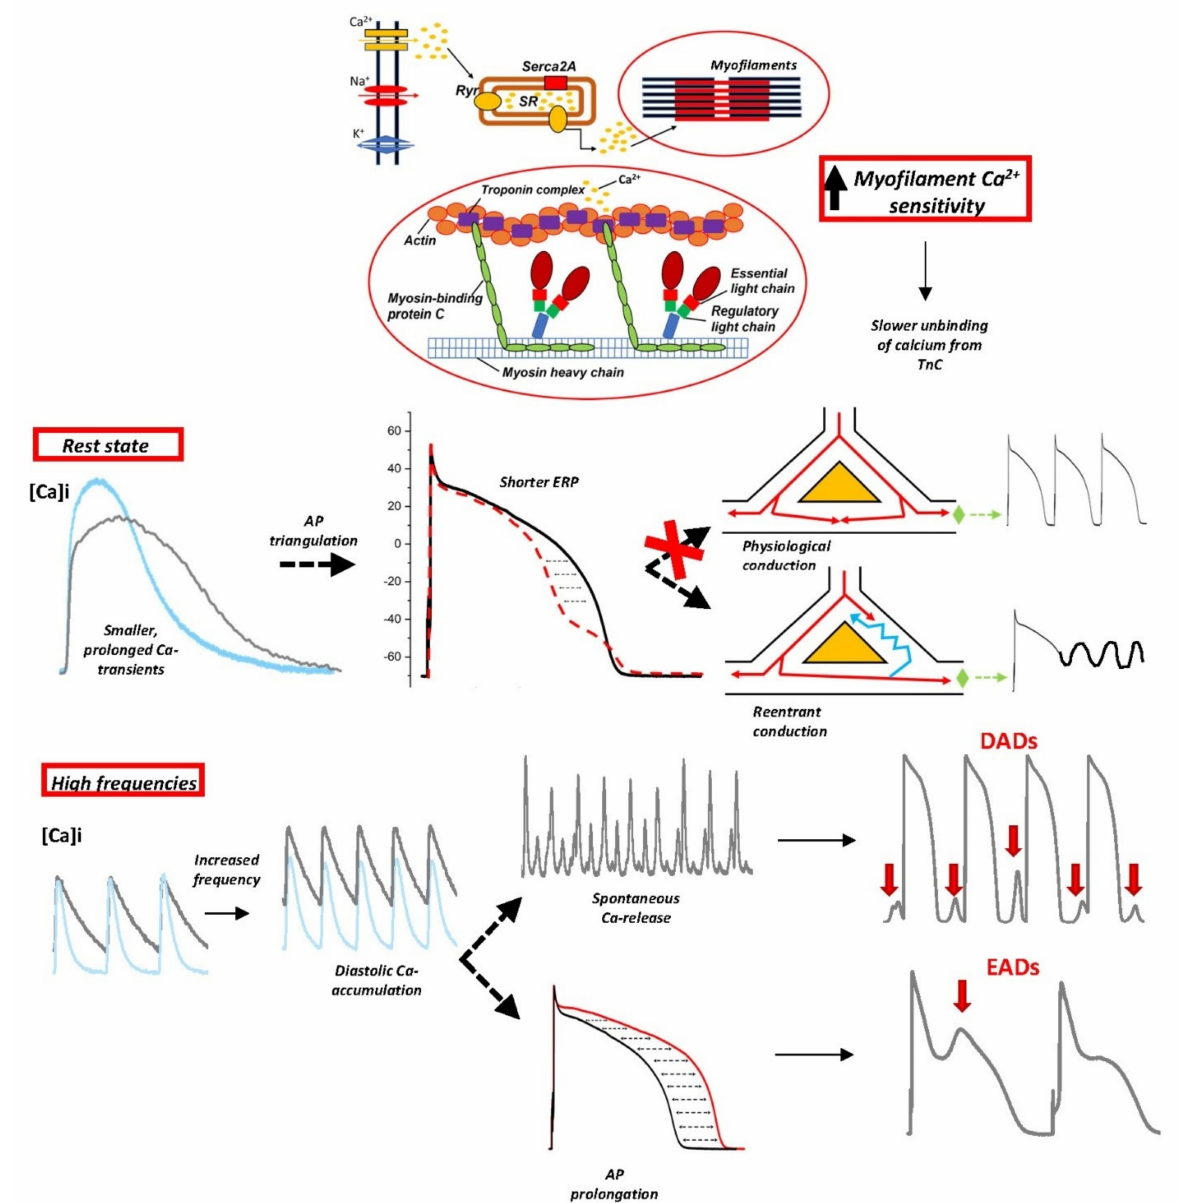
Figure 2. Myofilament Ca 2+ sensitization as an arrhythmogenic mechanism in HCM. The increased sensitivity to Ca of the troponin complex in HCM cardiomyocytes causes a more prolonged binding of Ca to TnC and a slower detachment of the ion. This affects Ca-transients, which tend to be lower in amplitude and slower in their decay phase. This behavior is associated with triangulation of the AP, resulting in local shortening of the effective refractory period (ERP), rendering the tissue more susceptible to reentry arrhythmias. Moreover, the accumulation of diastolic Ca at higher pacing rates sensitizes the ryanodine receptors, thus increasing the likelihood of spontaneous diastolic openings, calcium waves and thus late-phase EADs and DADs. A sudden prolongation of APs due to Ca accumulation further raises the probability of afterdepolarizations. Traces modified from Coppini et al. [26], Coppini et al. [56], and Ferrantini et al.